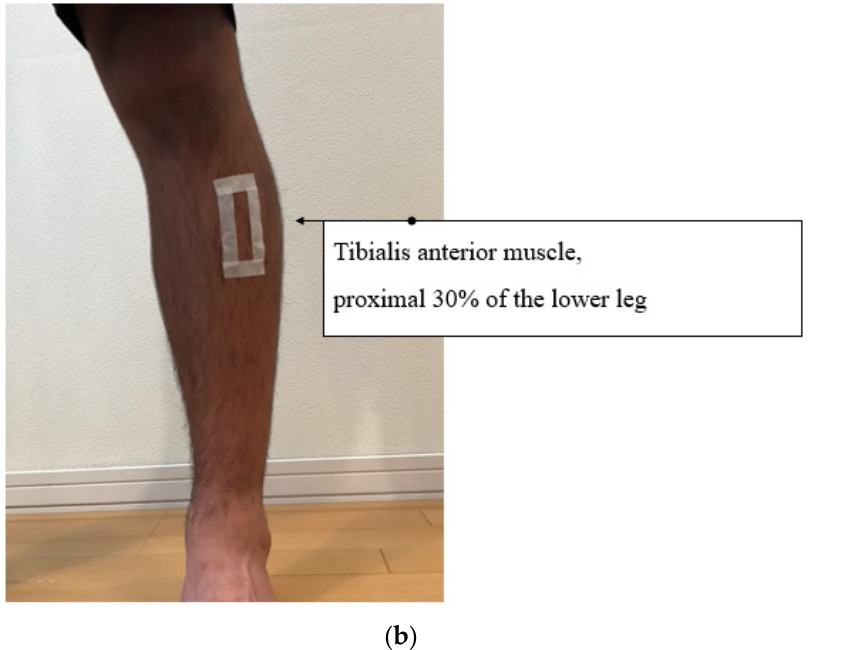
Figure 3. Left lower leg of a participant. ( a ) Sites of recording of shear wave velocity at lateral, medial gastrocnemius, and soleus muscles. ( b ) Sites of recording of shear wave velocity at tibialis anterior muscle. Permission with Plos One 2021 [21].